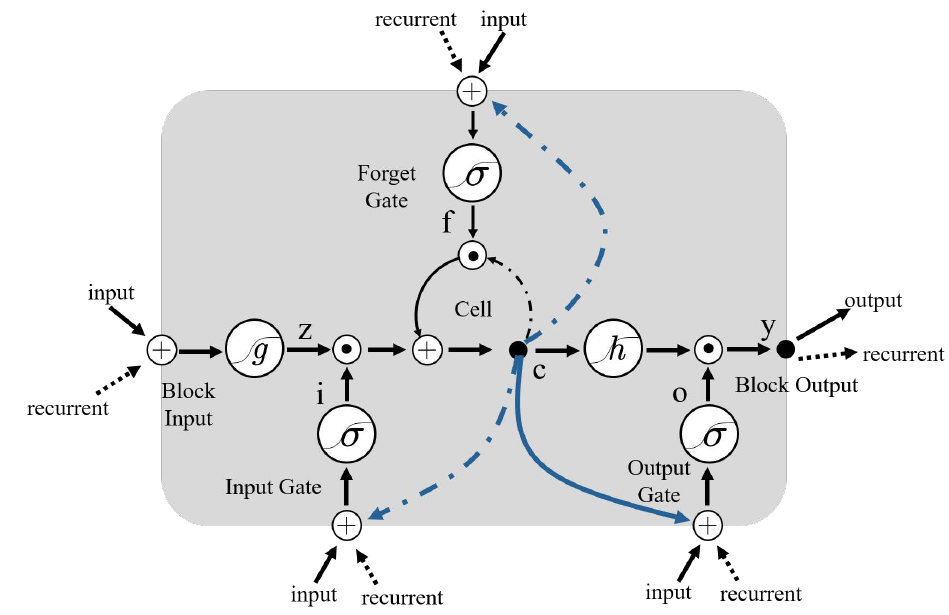
Figure 12. The structure of an LSTM cell.